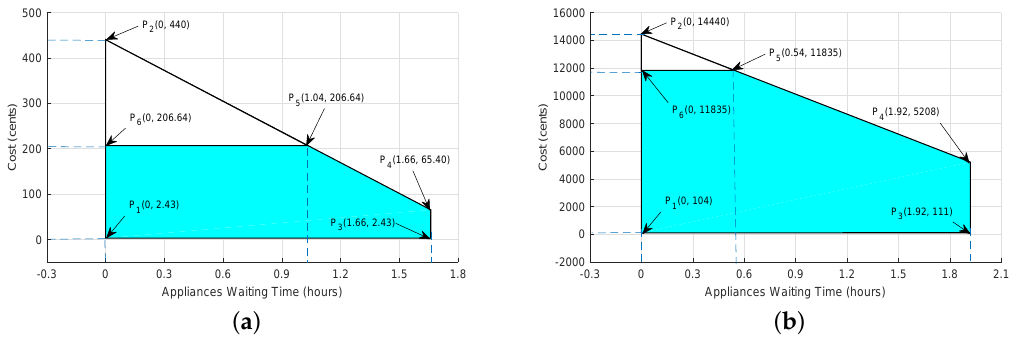
Figure 7. Feasible region for cost and waiting time using CPP. ( a ) Feasible region for a single home; ( b ) feasible region for multiple